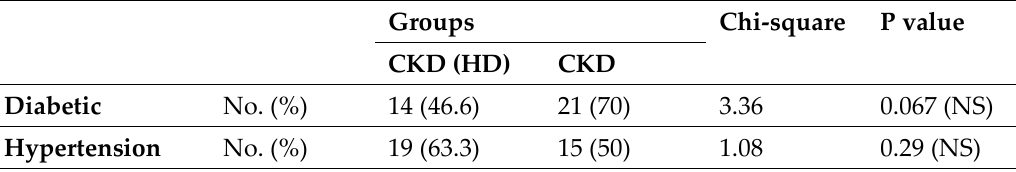
Table 2: Medical history of chronic kidney disease patients.